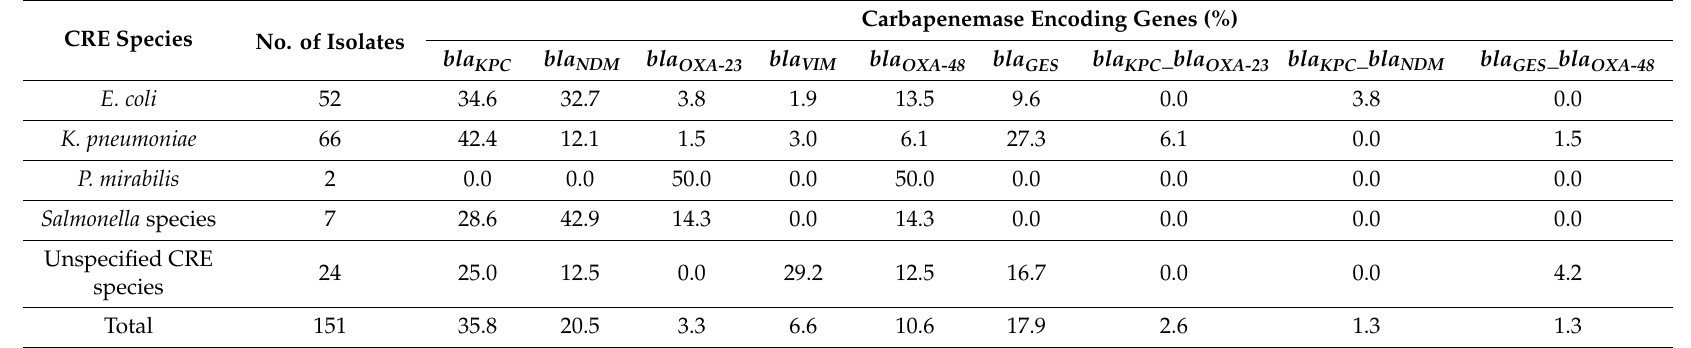
Table 1. Proportion of CRE species harbouring carbapenemase